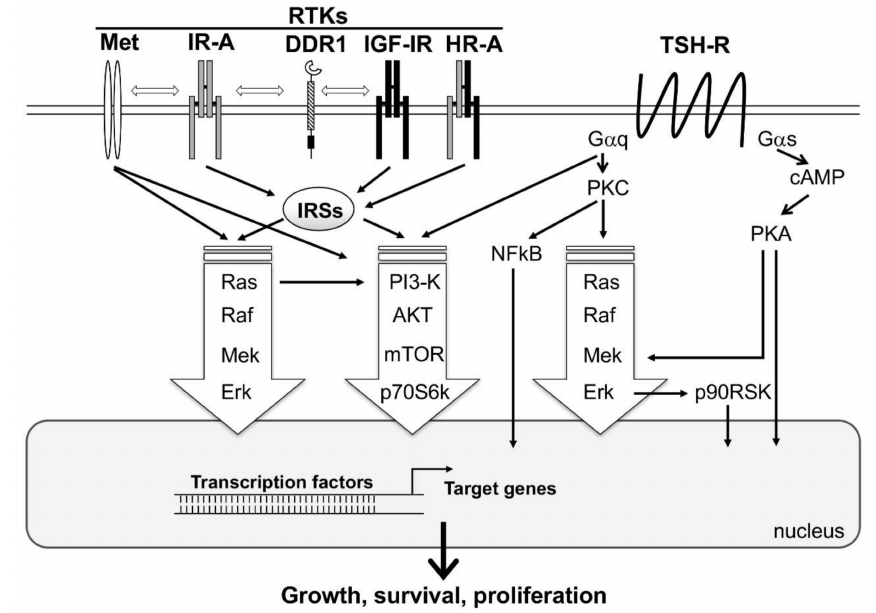
Figure 1. A simplified representation showing the interplay between the major signaling cascades activated by tyrosine kinase receptors (RTKs) and TSH-Receptor (TSH-R). Activation of TSH-R on the cell surface by TSH results in the activation of two major classes of G proteins, namely G α q and G α s. G α s, through the second messenger, cAMP, activates the major signaling pathway PKA/Mek/Erk. In addition, PKA may directly stimulate transcription factors in the nucleus, resulting in the activation of target genes involved in thyroid follicular cells function, growth, and survival. G α q activates the signaling cascades PKC/Ras/Raf/ERK/p90RSK, PI3-K/AKT/mTOR/p70S6k, and PKC/NFkB. RTKs (i.e., Met, IR-A, DDR1, IGF-1R and HR-A) directly or via IRSs, induce MAPK (Ras/Raf/Mek/Erk) and PI3-K/AKT/mTOR/p70S6k signaling cascades. All these pathways interact with each other, resulting in a multitude of cross-talks. MAPK and PI3-K cascades are common to both TSH-R and RTKs downstream-mediated signaling, and are represented with big arrows, as they are the major players of follicular cell